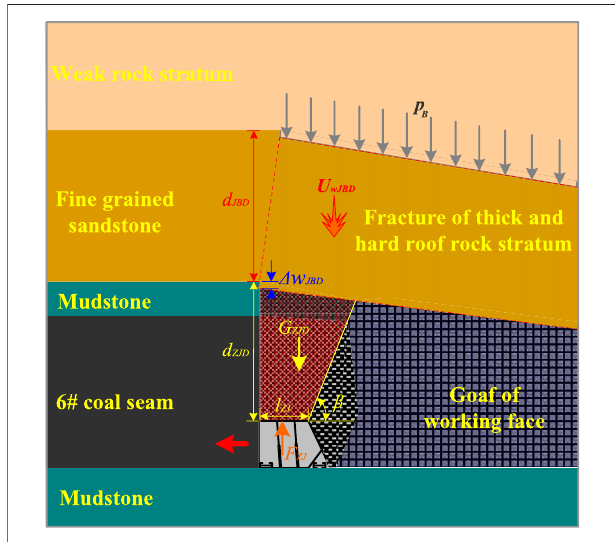
FIGURE 8 | Schematic diagram of the dynamic load response mechanical analysis of the hydraulic support in the working